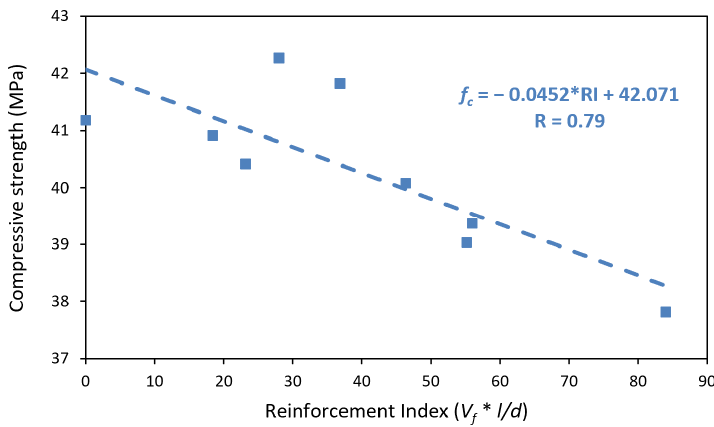
Figure 7. Correlation between the reinforcement index and compressive strength.